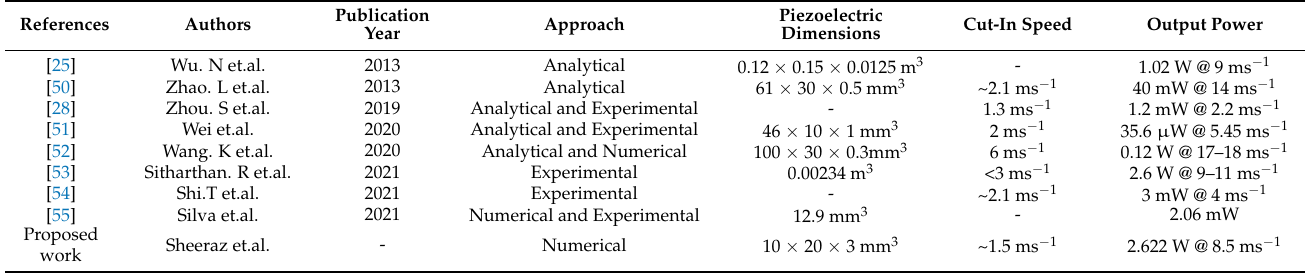
Table 4. Comparison of wind energy harvesters based on the piezoelectric technique.